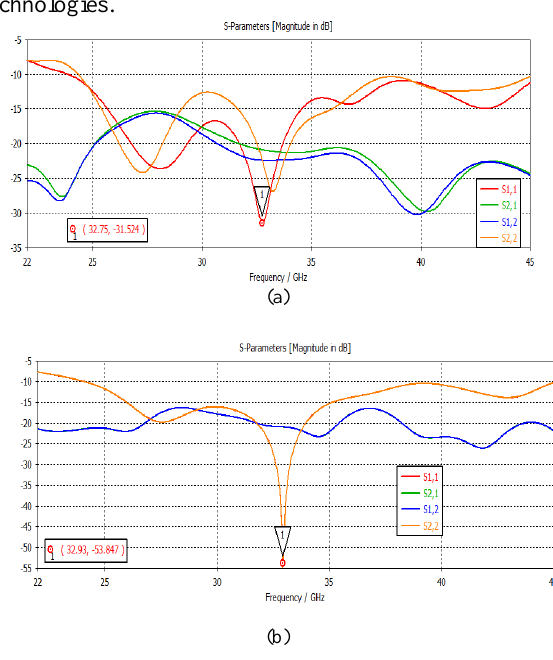
Fig.6. Simulated Sij result of the proposed antenna vs. Frequency; (a) of the first MIMO configuration and (b) of the second MIMO configuration.